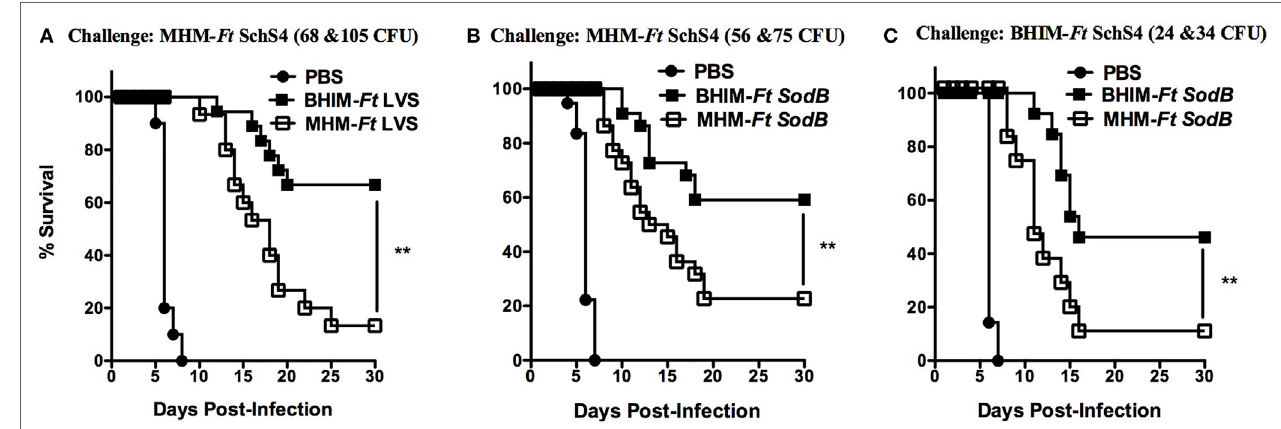
FigUre 3 | Vaccination with live brain-heart infusion medium (BHIM)- Francisella tularensis ( Ft ) provides better protection against Ft SchuS4 challenge C57BL/6 male and female mice were immunized i.d. with either 50 µl of vehicle (PBS) or 50 µl of 1 × 10 3 CFU of BHIM versus Mueller-Hinton medium (MHM)- Ft LVS (a) or BHIM versus MHM- Ft sodB (B,c) on day 0 and boosted i.n. on day 21 with either 20 µl of vehicle (PBS) or 20 µl of 1 × 10 3 CFU of BHIM versus MHM- Ft LVS or BHIM versus MHM- Ft sodB . Mice were then challenged i.n. on day 42 using MHM (a,B) or BHIM (c) - Ft SchuS4 and subsequently monitored for 30 days for survival. Data shown are representative of two independent experiments. ** p <